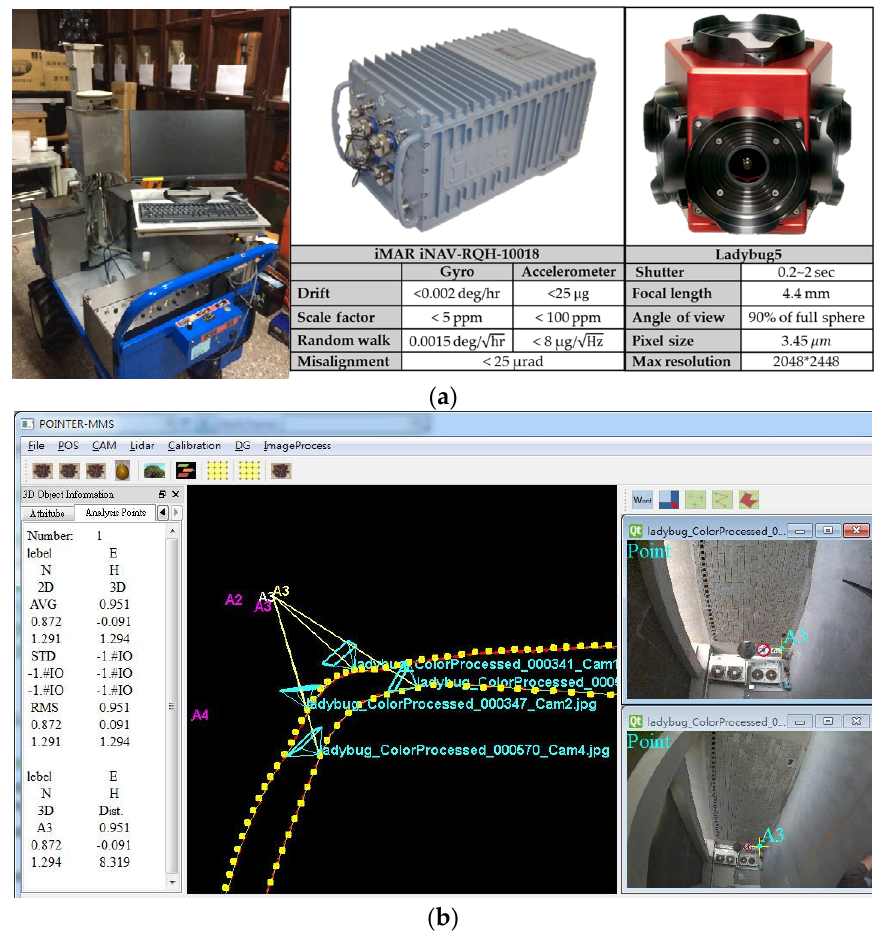
Figure 2. The developed IMMS: ( a ) The exterior of IMMS and the specifications of the used high-grade IMU and 360-degree spherical camera system; ( b ) The developed software for direct geo-referencing.